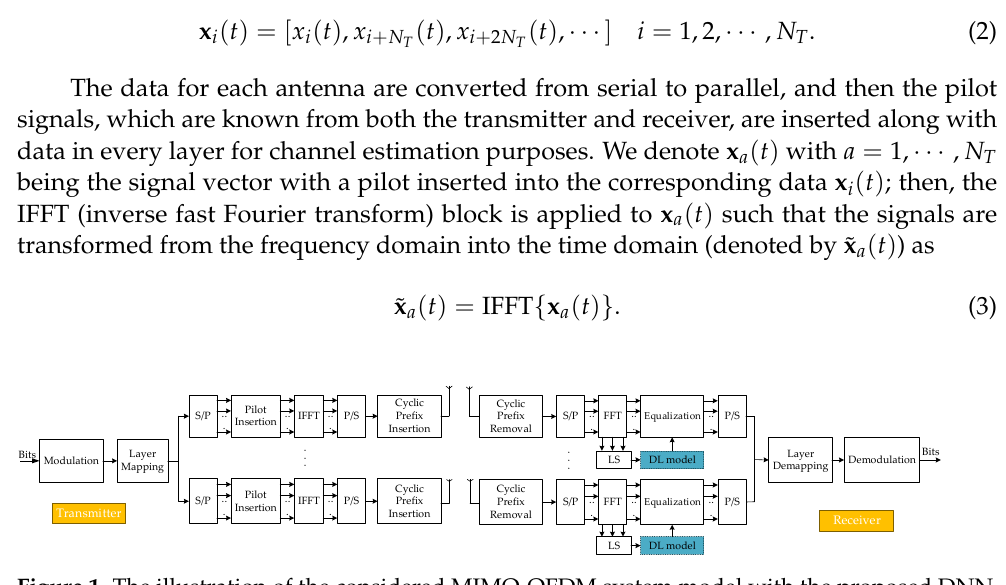
Figure 1. The illustration of the considered MIMO-OFDM system model with the proposed DNN- aided module in blue. In the figure, CP denotes cyclic prefix; S/P denotes serial to parallel; P/S de- notes parallel to serial; IFFT denotes inverse fast Fourier transform; and FFT denotes fast Fourier trans-